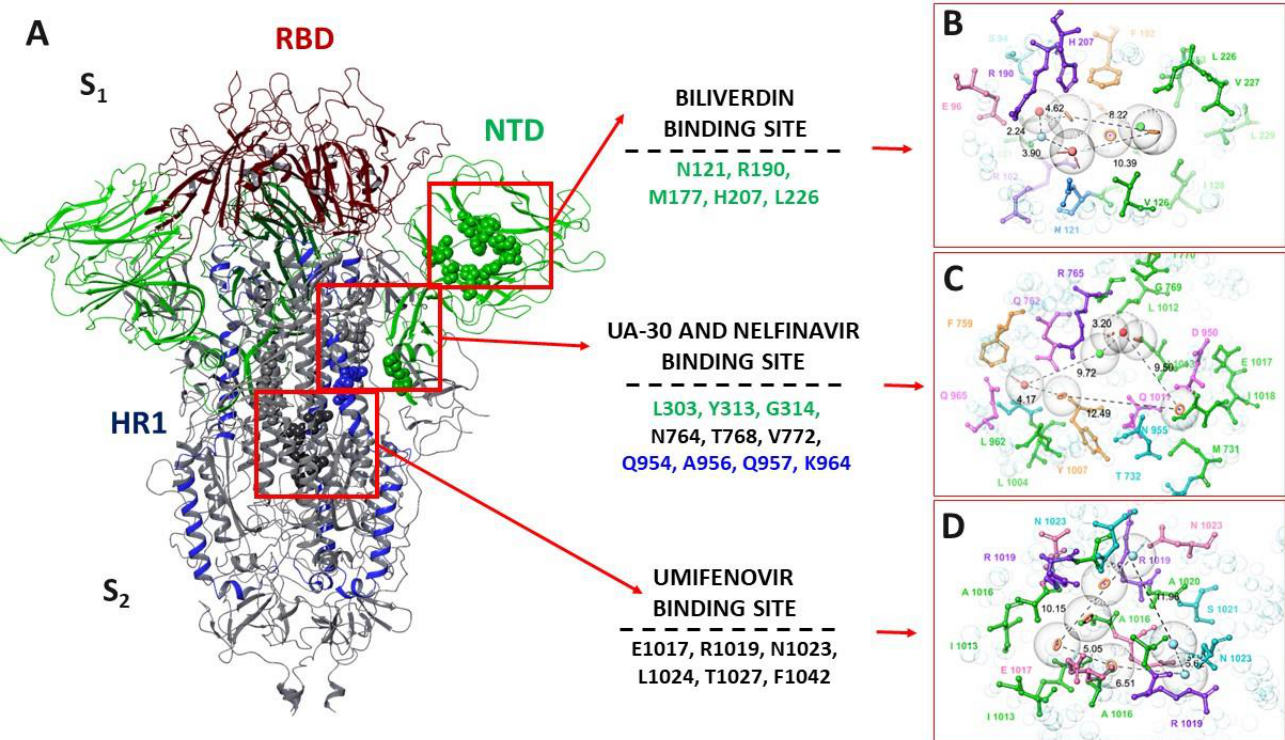
Figure 4. ( A )—Secondary structure of the SARS-CoV-2 surface protein. Visualization based on the PBD code 7BNM [33]: the secondary structure of the N-terminal domain (amino acids 14–330) is shown in green; the receptor-binding domain (amino acids 330–528) is shown in dark red; heptad repeats (amino acids 910–985) are shown in blue. ( B – D )—Pharmacophore profile of inhibitor binding sites. The dots indicate the required pharmacophoric features of the potential ligand: green ball corresponds to the hydrophobic feature; blue and pink correspond to the donor and acceptor, respectively; orange indicates aromatic rings; red indicates negatively charged. The distances between the pharmacophore features are indicated in Å. Amino acids are shown within 4 Å of the likely location of the ligand. Neutral hydrophobic aliphatic amino acids are colored green; basic hydrophilic amino acids are colored purple; neutral hydrophilic amino acids are colored blue; neutral hydrophobic aromatic amino acids are colored orange; hydrophilic acidic amino acids are shown in pink.